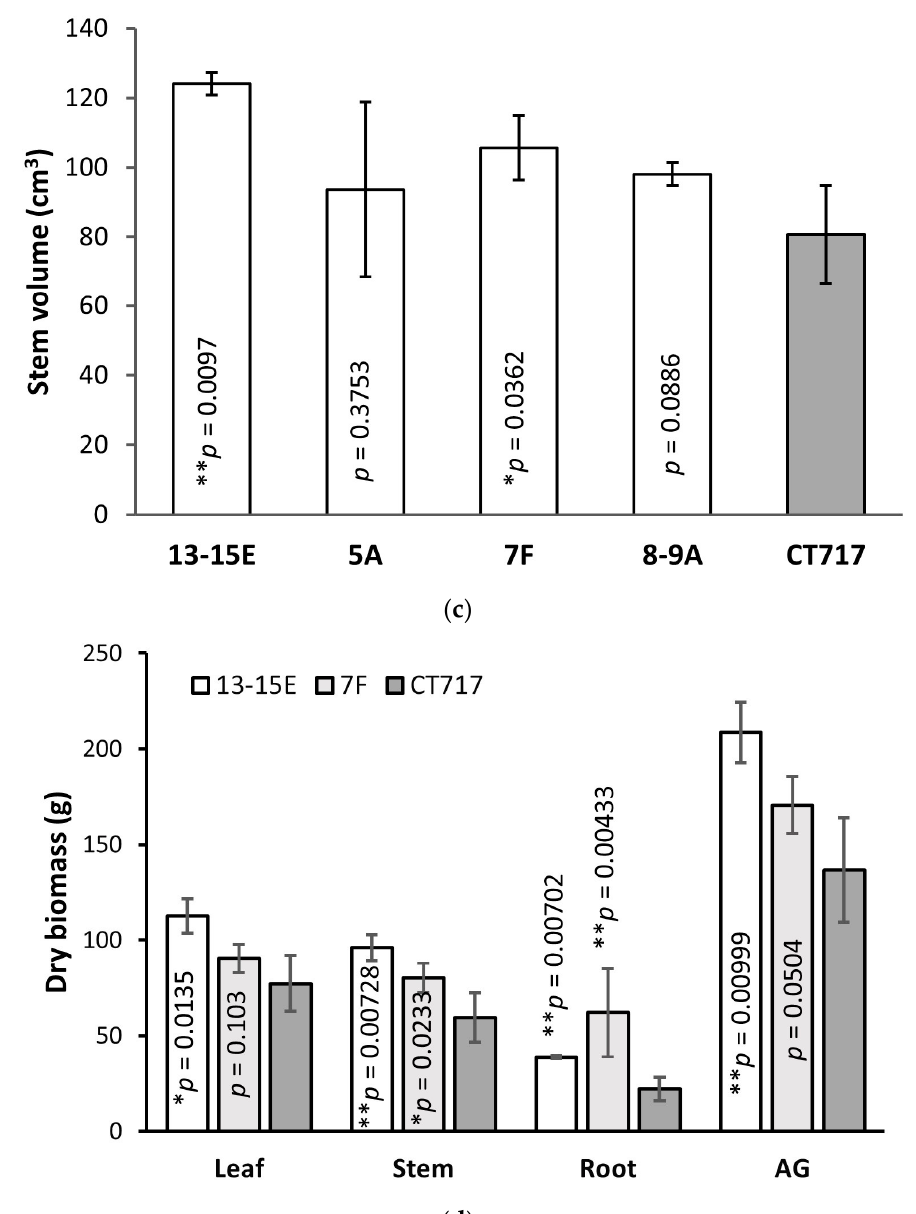
Figure 4. Photosynthetic activity and plant growth analysis in selected transgenic events. ( a ) A-Ci curve was generated from C1 experimental plants, 18 weeks old. Number of ramets: CT717 non- transgenic control, 5; Event 13-15E, 2; Event 7F, 3. Error bars indicate SEM. ( b ) C1 experimental plant height difference between transgenic plants and CT717 before harvesting for biomass measurement at Week 21. Left: 13-15E, 2 ramets; Right: 7F, 3 ramets; Middle: CT717, 5 ramets. ( c ) Average stem volume of C1 experimental plants at Week 17. ( d ) Dry biomass of harvested C1 experimental plants, including leaf, stem, root, and above-ground (AG) leaf + stem. Number of ramets: CT717 control plants, 5; Event 13-15E, 2 (one of the three initial ramets died earlier in the experiment); Event 7F, 3. All p -values were calculated using t-test and represent the difference compared to the non-transgenic CT717 control plants. * and ** represents a significant difference at p < 0.05 and p < 0.01, respectively when compared to non-transgenic CT717.